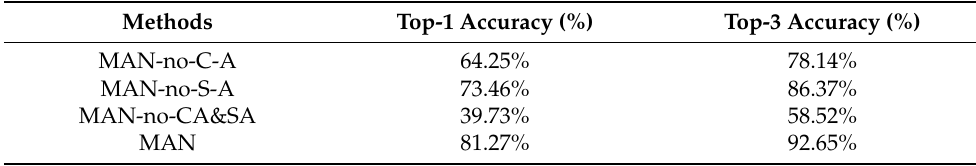
Table 4. Experimental results with the different structures of